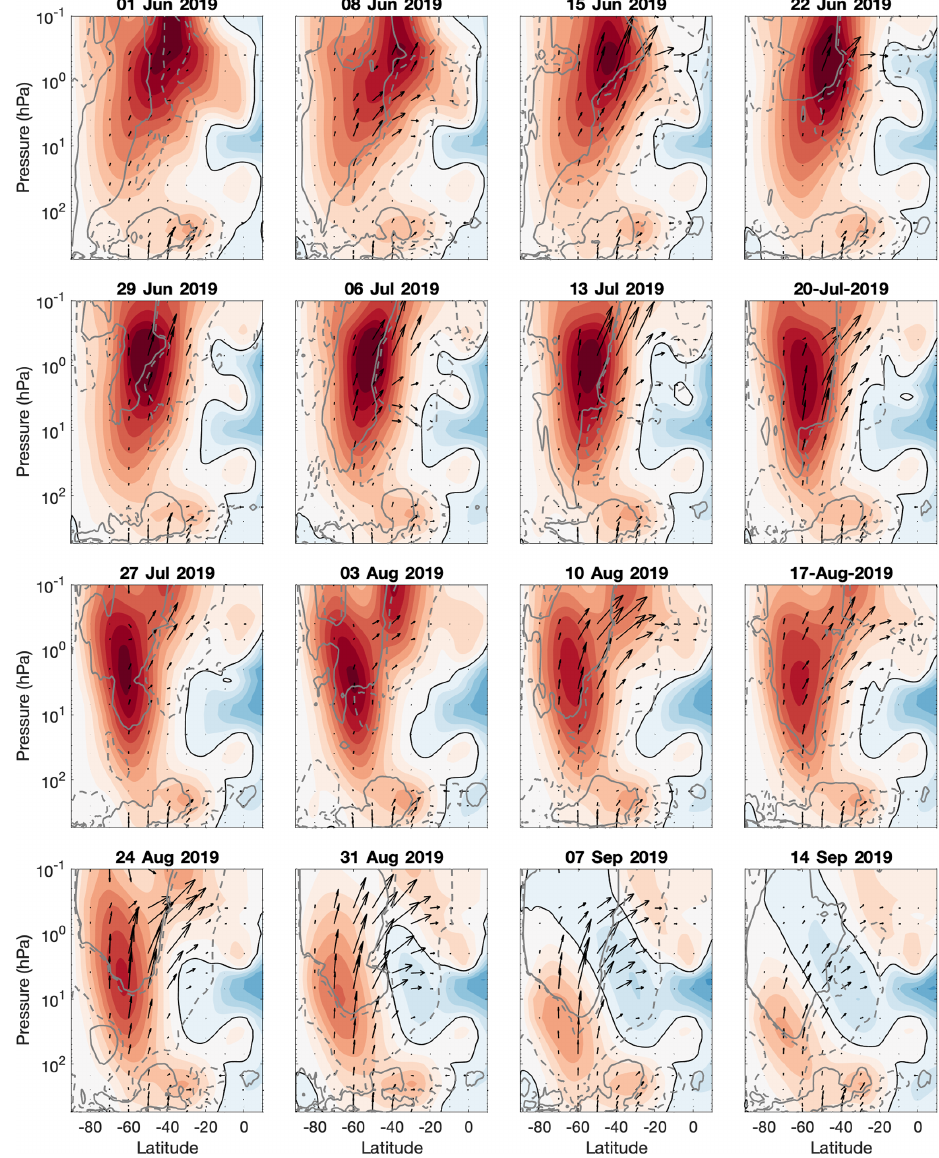
Figure 2. The same as Fig. 1 but for the year